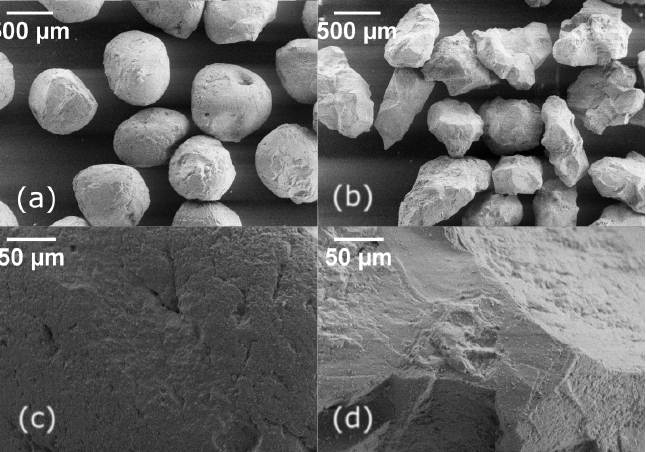
Figure 2. SEM micrographs of ( a ) Ottawa sand grains and ( b ) Q-Rok grain at 94 × magnification; Texture of ( c ) Ottawa grain and ( d ) Q-Rok grain at 1000 ×